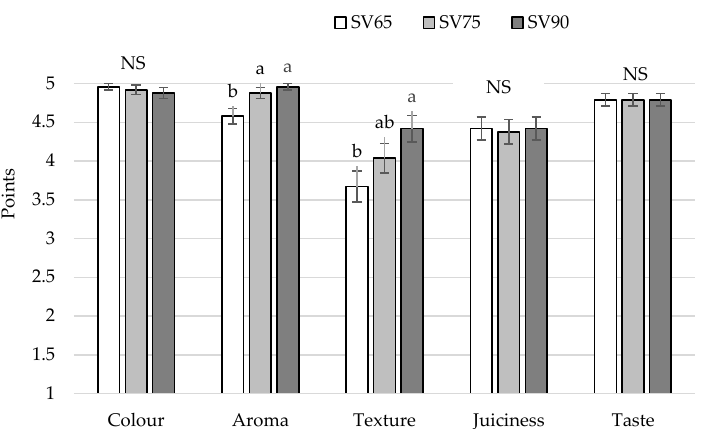
Figure 3. Comparison of fatty acids content (mg/100 g) in pikeperch fillets: raw and after sous vide treatment proceeded at 65 °C for 45 min (SV65), 75 °C for 20 min (SV75), and 90 °C for 10 min (SV90); vertical bars refer to standard error of the mean; a,b—values denoted with different letters differ significantly at p < 0.05; NS—no significant differences; EPA—eicosapentaenoic fatty acid; DPA—docosapentaenoic fatty acid; DHA—docosahexaenoic fatty acid.